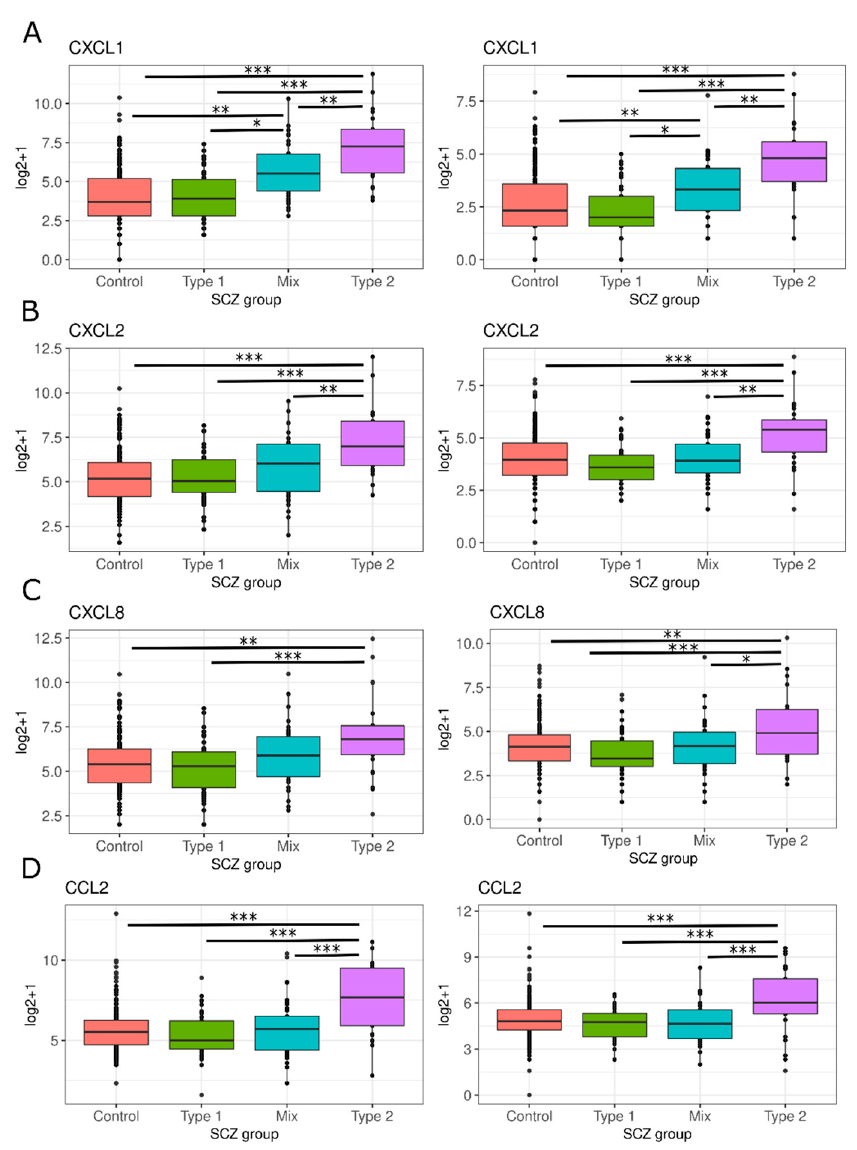
Figure 9. Chemokine’s expression across SCZ subtypes: ( A ) CXCL1, ( B ) CXCL2, ( C ) CXCL8, ( D ) CCL2. Boxplot of the log2+1 expression data is shown for each SCZ group: Controls (red), Type 1 (green), Mix (blue) and Type 2 (purple). Graphs on the left are polyA and graphs on the right are riboZ. * p -value < 0.05, ** p -value < 0.01, *** p -value < 0.001 via Tukey HSD.